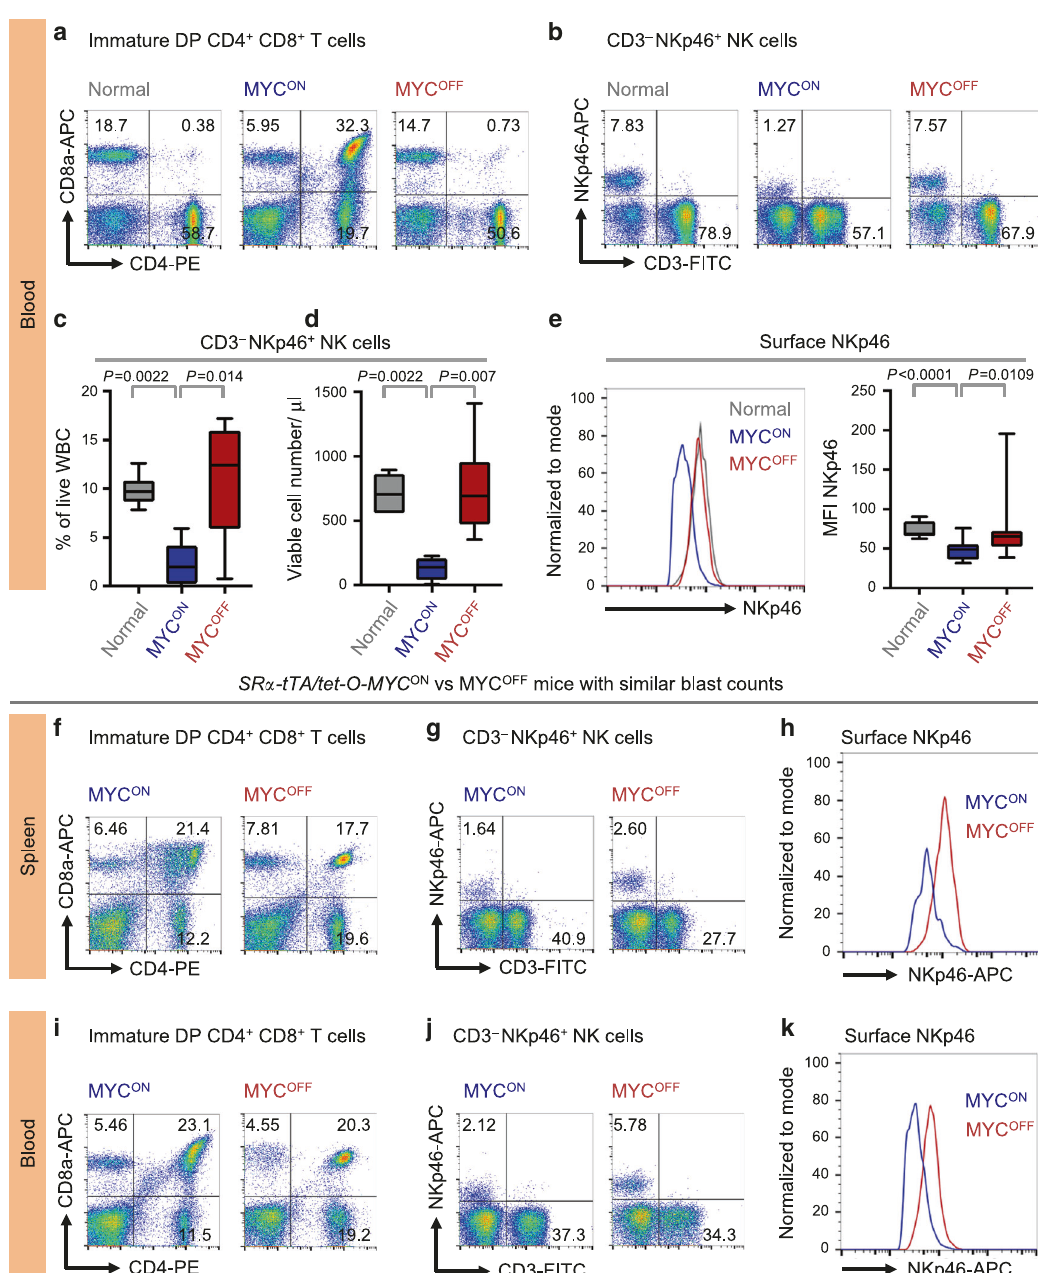
Fig. 2 NK cell suppression in MYC-driven lymphomas is systemic and depends on MYC status. a , b Representative fl ow cytometry plots depicting percentages of circulating immature CD4 + CD8 + T ( a ) and CD3 − NKp46 + NK ( b ) cells in normal ( n = 6), SR α -tTA MYC ON ( n = 6) and SR α -tTA MYC OFF (doxycycline 96 h, n = 6) mice. c , d Quanti fi cation of percentages ( c ) and absolute counts per μ l of blood ( d ) of CD3 − NKp46 + NK cells, in normal ( n = 6), SR α -tTA MYC ON ( n = 6), and SR α -tTA MYC OFF (doxycycline 96 h, n = 6) mice. e Comparison of MFI of surface NKp46 on circulating NK cells in normal ( n = 6), SR α -tTA MYC ON ( n = 6) and SR α -tTA MYC OFF (doxycycline 96 h, n = 6) mice. f , g Representative fl ow cytometry plots depicting percentages of splenic immature CD4 + CD8 + T ( f ) and CD3 − NKp46 + NK ( g ) cells in SR α -tTA MYC ON and SR α -tTA MYC OFF (doxycycline 96 h) mice with comparable blast counts. h Comparison of surface NKp46 levels (MFI) on splenic NK cells from SR α -tTA MYC ON and SR α -tTA MYC OFF (doxycycline 96 h) mice with comparable blast counts. i , j Representative fl ow cytometry plots depicting percentages of circulating immature CD4 + CD8 + T ( i ), and CD3 − NKp46 + NK ( j ) cells in SR α -tTA MYC ON and SR α -tTA MYC OFF (doxycycline 96 h) mice with comparable blast counts. k Comparison of surface NKp46 levels (MFI) on circulating NK cells from SR α -tTA MYC ON and SR α -tTA MYC OFF (doxycycline 96 h) mice with comparable blast counts. p -values have been calculated using a two-sided Mann – Whitney test. ns not signi fi cant. For all box plots, the center is at the median, minima and maxima are indicated by whiskers, and the box represents data between the 25th and 75th